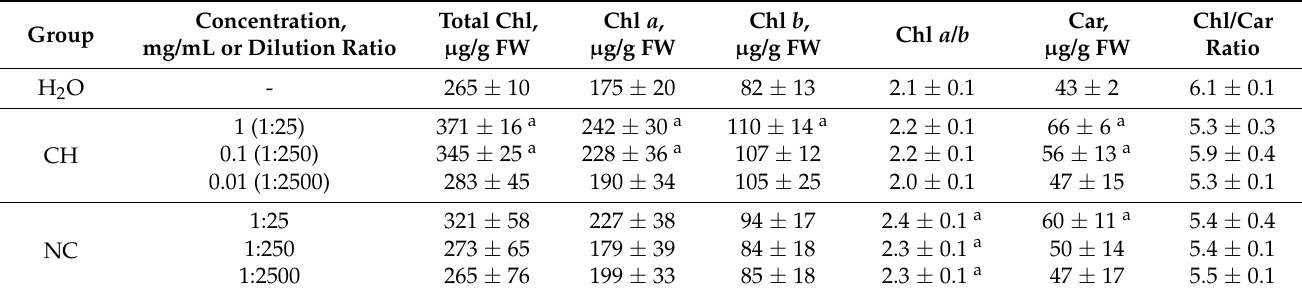
Table 3. Effect of CH, NC, and H 2 O on photosynthetic pigments in dependence of concentration at the 10th DAS.